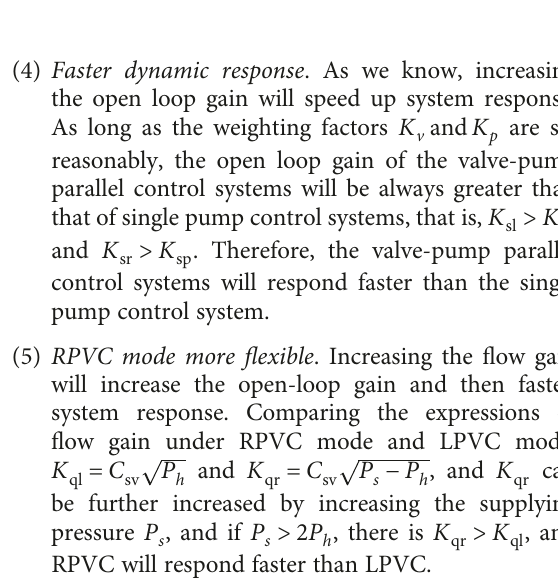
Figure 6: Experimental system in valve-pump parallel variable mode